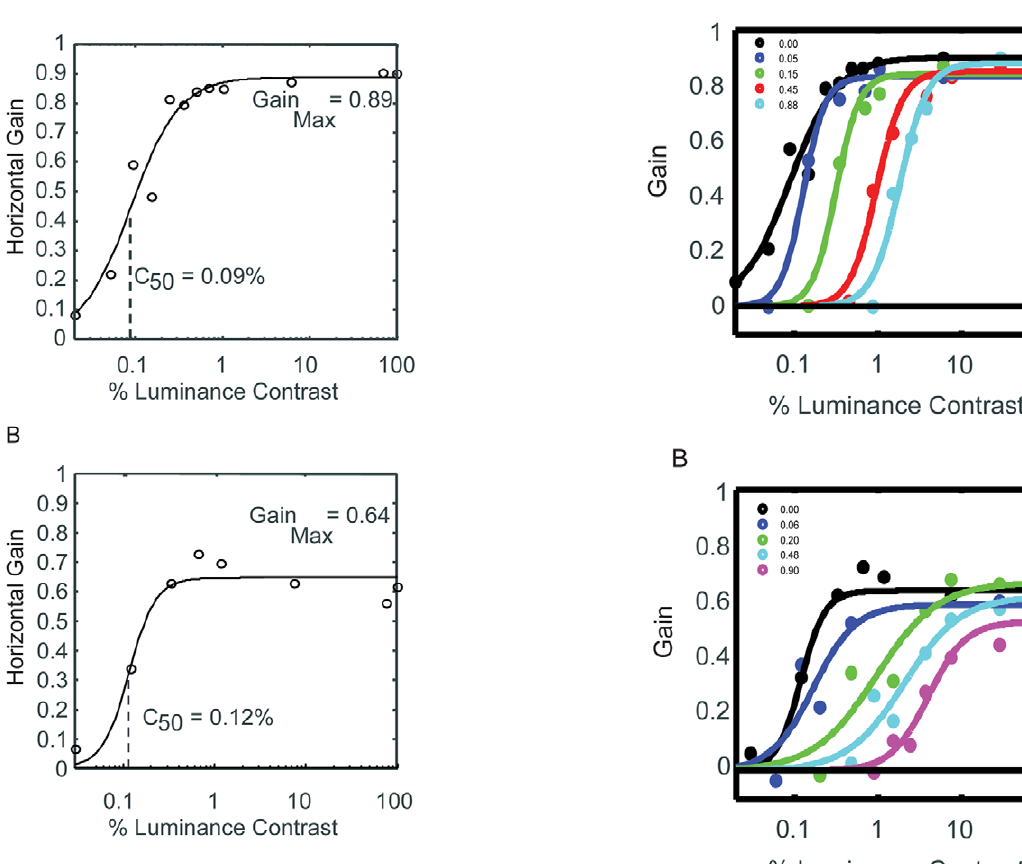
Figure 3. Contrast-dependent Oculomotor Gain Function. Oculomotor gain is plotted as a function of contrast. The data is fitted to the function: Gain = Gain Max * X n /(X n + C 50n ), where Gain Max is the maximum estimated gain and C 50 is the contrast that results in 50% of the maximum gain. A. The contrast-dependent oculomotor gain function (COGF) is plotted for Monkey A. In this subject, the maximum gain was 89% of the dot velocity, and the C 50 point was 0.09% RMS- contrast. B. For Monkey B, the maximum gain was 64% of the dot velocity, and the C 50 point was 0.12% RMS-contrast.